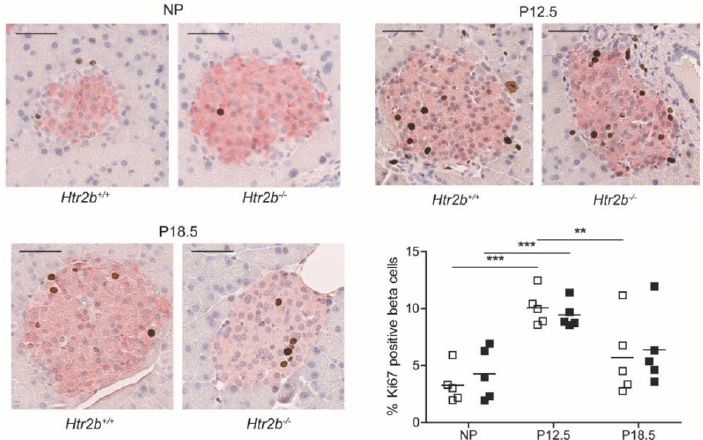
Figure 10. Normal pregnancy-stimulated beta cell proliferation in Htr2b −/− mice. Representative images show one pancreatic islet from Htr2b +/+ and Htr2b −/− mice that were studied in non-pregnant animals or during pregnancy (P12.5 and P18.5). Proliferating insulin-positive beta cells with nuclear presence of Ki67 (pink cytoplasm and brown nucleus) were counted. The highest levels of beta cell proliferation were P12.5 in both Htr2b +/+ mice ( □ ) and in Htr2b mice ( ■ ). Each square represents the analysis of one mouse pancreas, and—represents the mean. ** p < 0.01, *** p < 0.001.